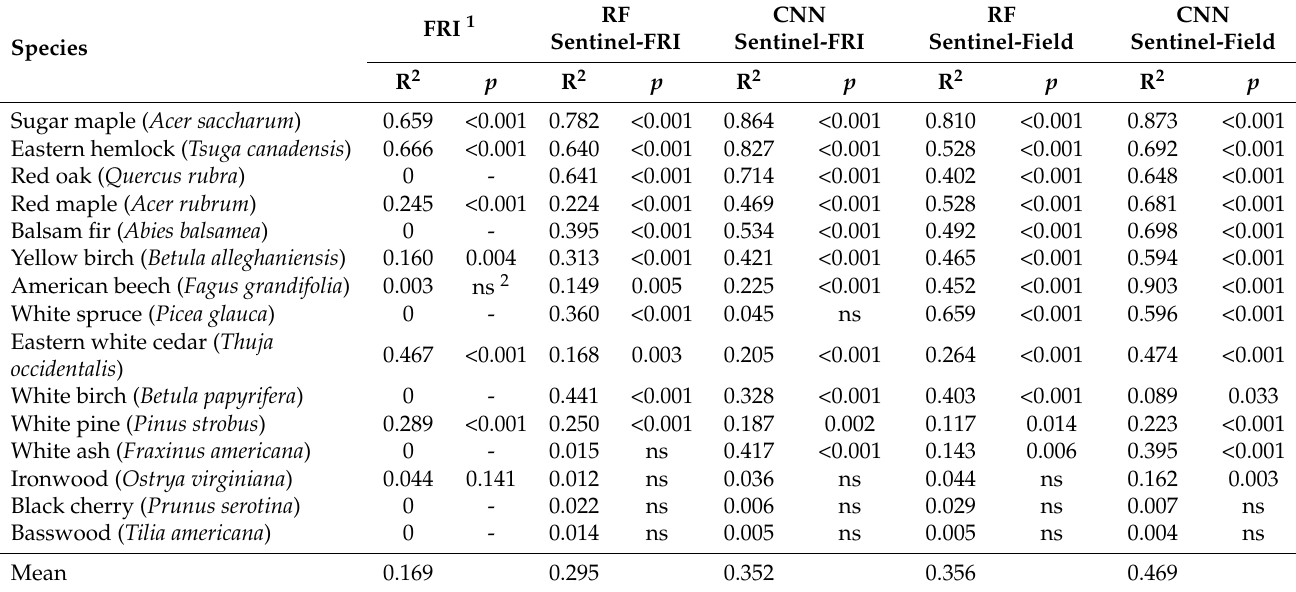
Table 2. As Table 1 except that the coefficients of determination are with percent basal area of stems >10 cm DBH in 51 0.24-ha field plots from the “Megaplot” in Haliburton Forest. The last two columns are for Sentinel-2 models (termed “Sentinel-field”) trained with information from 155 0.25-ha field plots in Haliburton Forest. Again, species order is based on average R 2 values (highest to lowest).